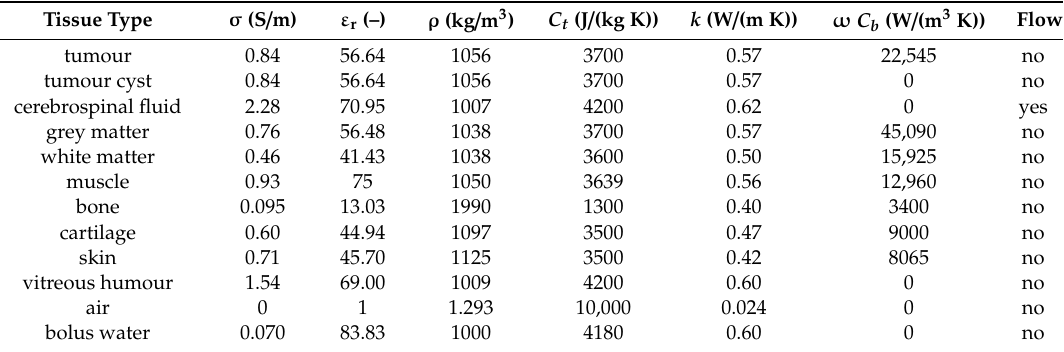
Table 1. Dielectric and thermal parameter values at 450 MHz for the various tissue types used in the simulations: electrical conductivity ( σ [S / m]), relative permittivity ( ε r [-]), density ( ρ [kg / m 3 ]), specific heat capacity ( C t [J / (kg K)]), thermal conductivity ( k [W / (m K)]) and perfusion coe ffi cient ( ω C b [W / (m 3 K)]), being the product of the volumetric perfusion rate ( ω [kg / (m 3 s)]) and the specific heat capacity of blood ( C b = 3600 W / (m 3 K). The last column indicates whether a tissue was modelled using convective flow simulations (“yes”), or using Pennes’ equation (“no”). Parameters were obtained